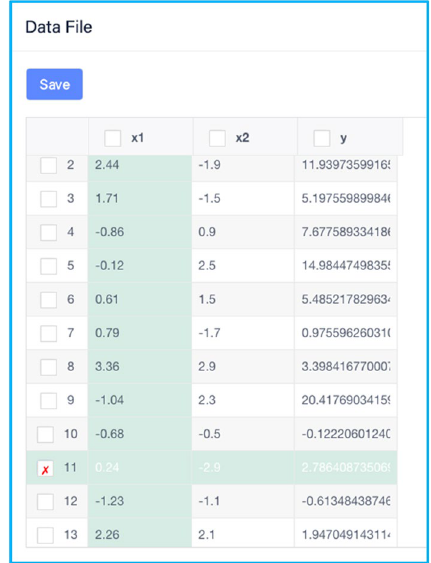
Figure 9 The data entry form of the output evaluation